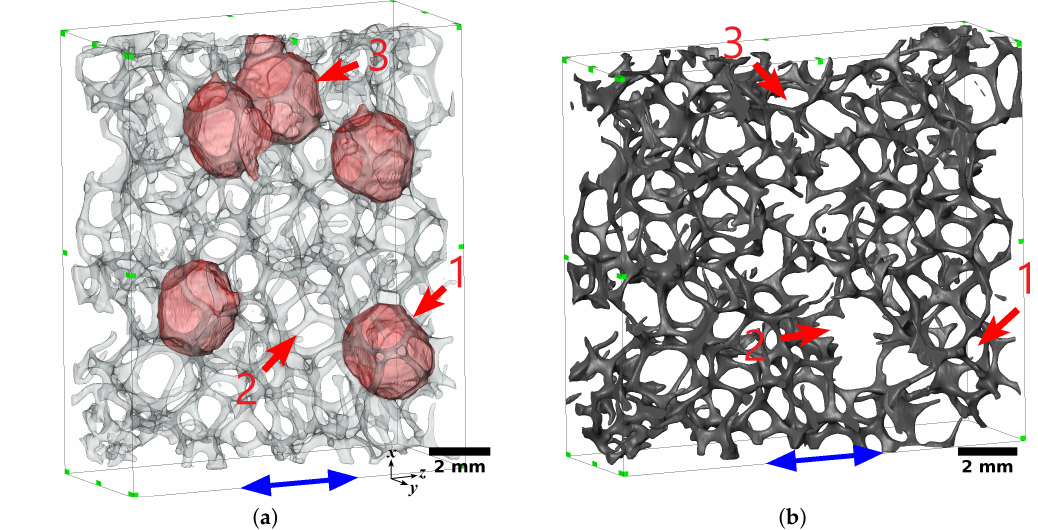
Figure 10. ( a ) The five biggest void-cells and ( b ) the final fractured state of the 30 PPI foam sample. The blue arrow indicates the loading direction. Cells of interest are labeled 1 to